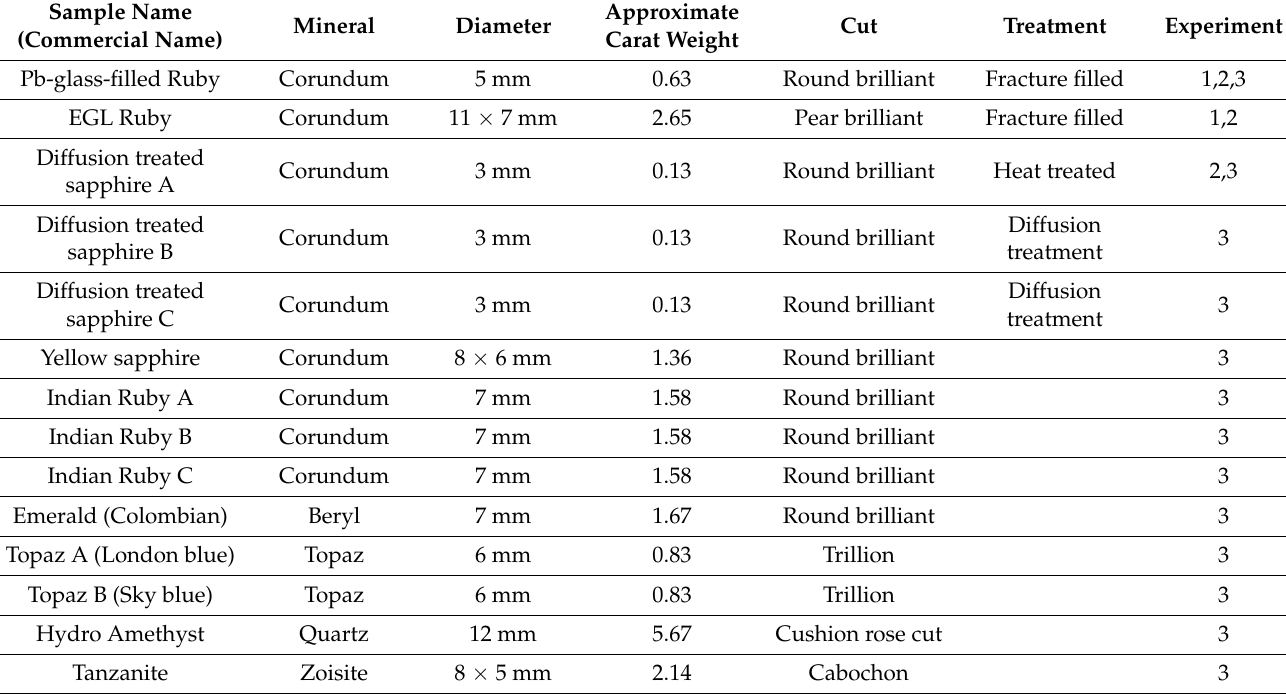
Table 1. Gemstones used in this